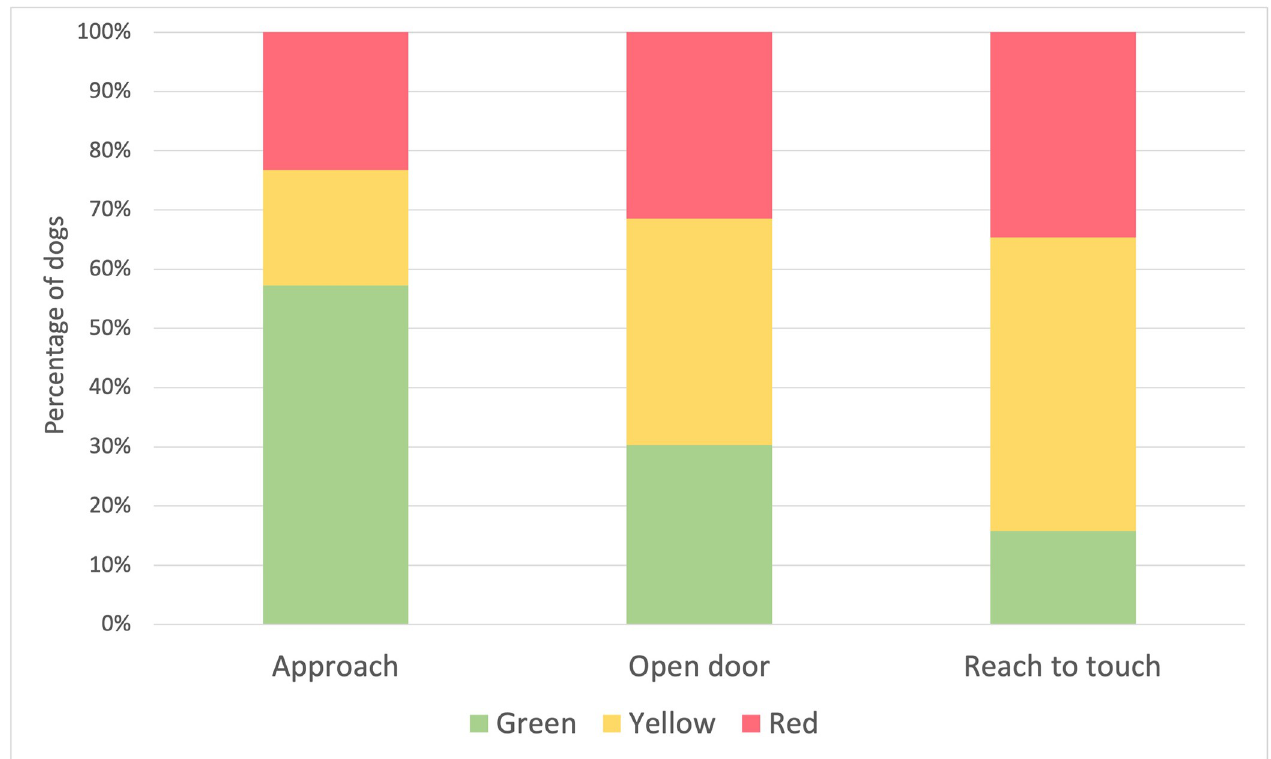
Fig 1. Dogs’ responses to the approach test. Percentage of tested dogs (total n = 589) scoring ‘red’ (showed signs of fear, aggression and/or stereotypic behavior), ‘green’ (showed affiliative approach, solicited attention or was undisturbed by the presence of the experimenter) or ‘yellow’ (showed ambivalent approach-avoidance behavior, or were not clearly ‘red’ or ‘green’) during the three-step approach test (i.e., approach, open door and reach to touch).